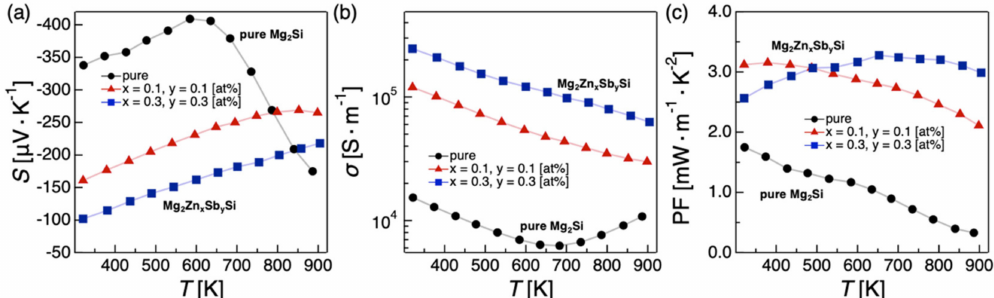
Figure 4. ( a ) Seebeck coefficient ( S ), ( b ) electrical conductivity ( σ ), and ( c ) power factor (PF) of the Mg 2 MSi (M = Sb, Zn) samples. (Reprinted by permission from Springer Nature: Springer, Journal of Electronic Materials , “Enhanced thermoelectric performance of vertical Bridgman-grown Mg 2 Si by codoping with Sb and Zn”, D. Shiojiri, T. Iida, H. Hamba, T. Kodama, M. Yamaguchi, N. Hirayama. and Y. Imai, Copyright 2022).